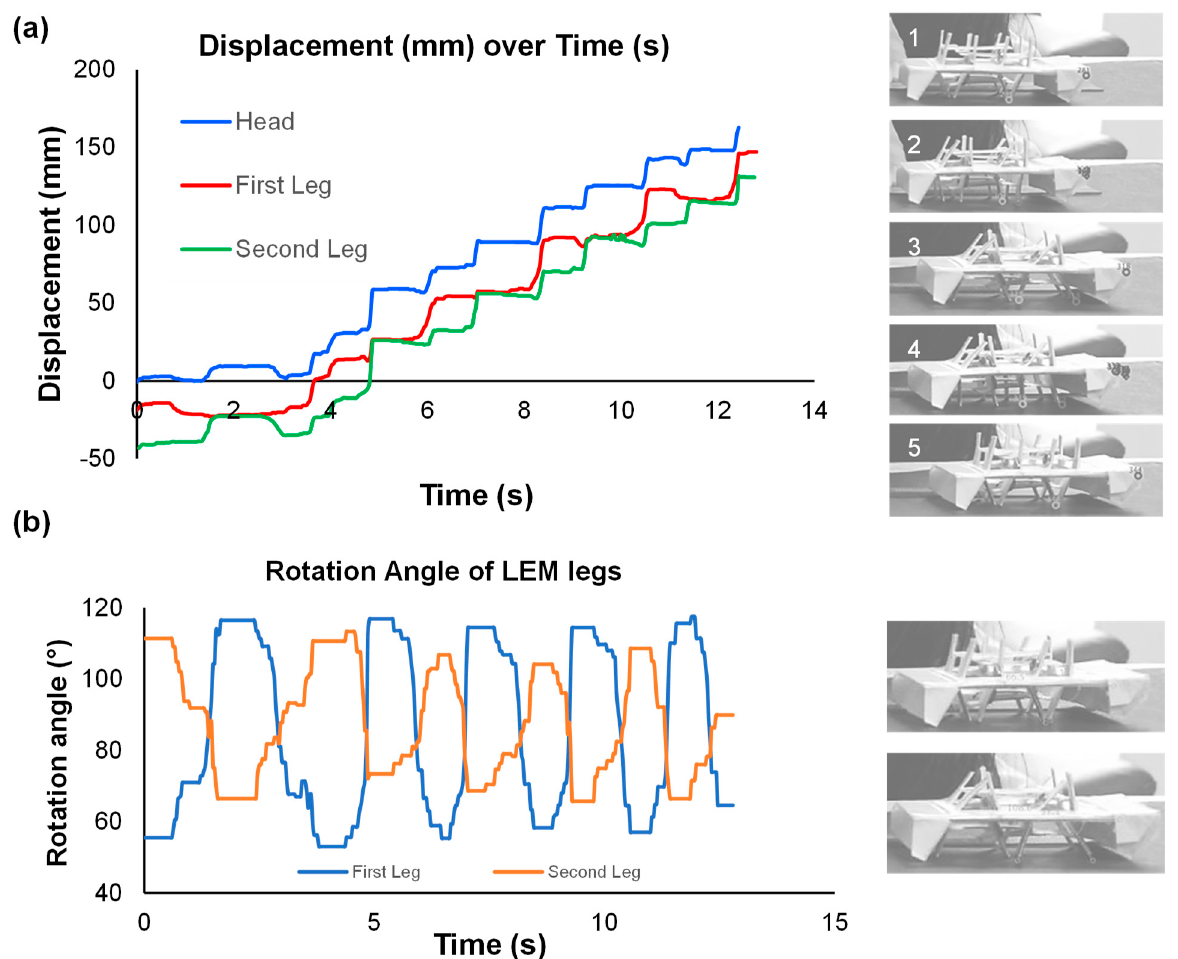
Figure 12. Locomotion of AMDLEM mechanism: ( a ) Displacement (mm) versus time (s) of the AMDLEM with alternating leg movement. Displacements of the alternating legs are recorded to show the alternating direction of movement. Overlapping regions can be seen in the displacement graph, representing the movement when the legs rotate toward each other and touch. ( b ) Graph of the rotation angle of 1st and 2nd legs shown in part ( a ) where the maximum value of the 1st leg and the minimum value of the 2nd leg corresponds with the overlapping regions of part ( a ), meaning the legs are touching.